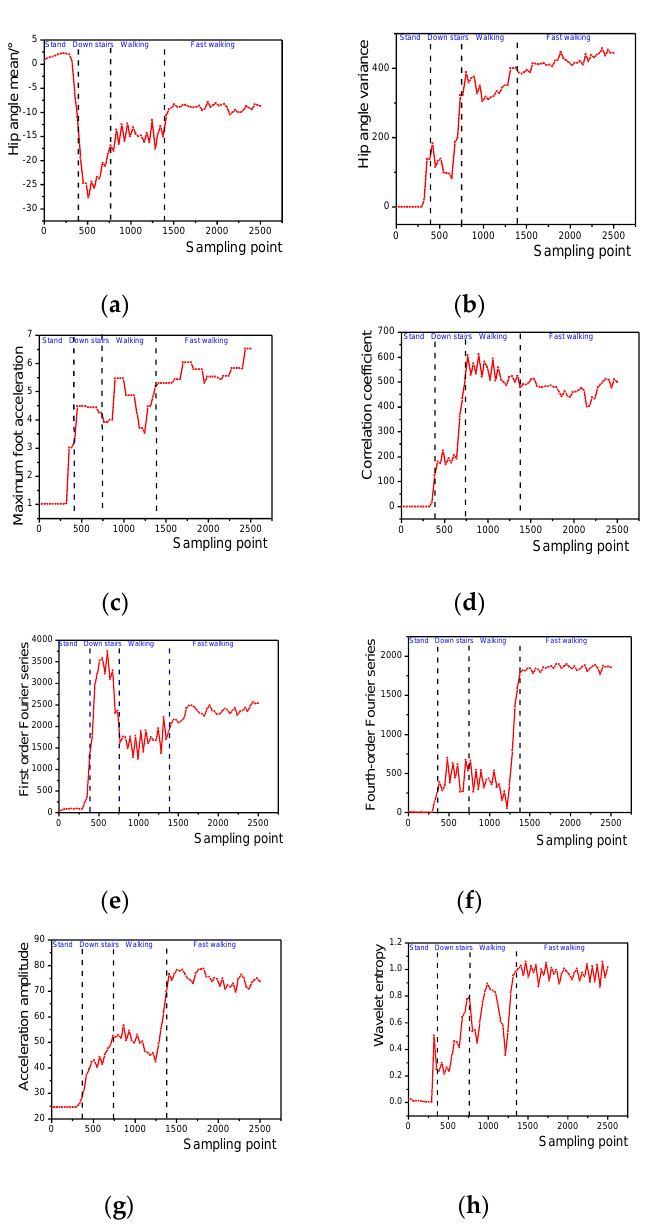
Figure 8. Hip joint angle and changes in the three-axis acceleration of the typical behavior.